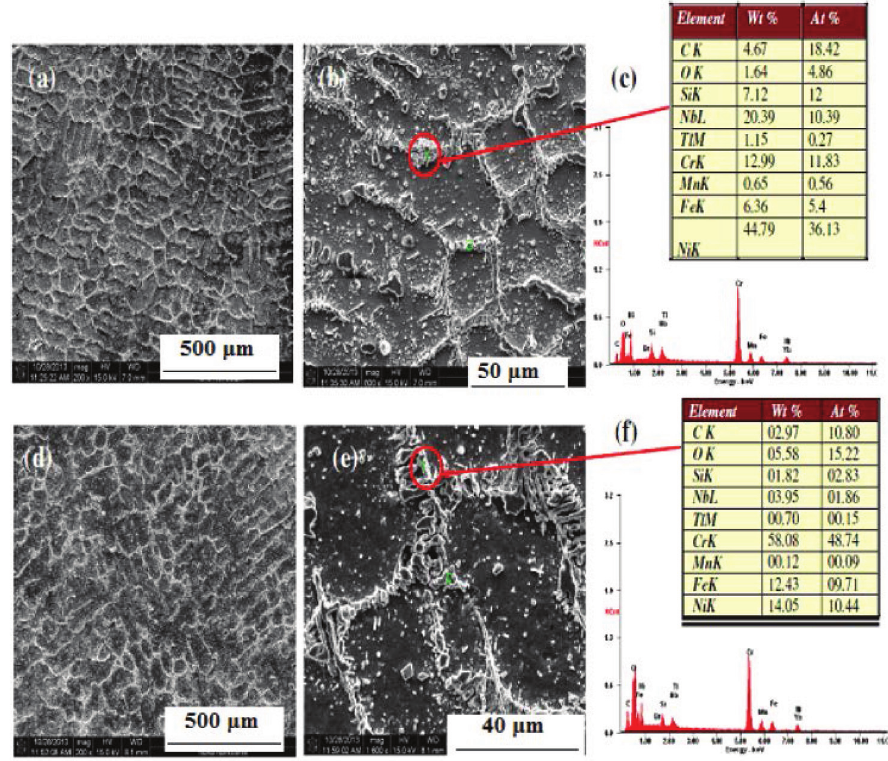
Figure 1: SEM micrograph reveal- ing microstructure of as received top and bottom portions of the reformer tube with EDAX analysis of Cr- and Nb-rich